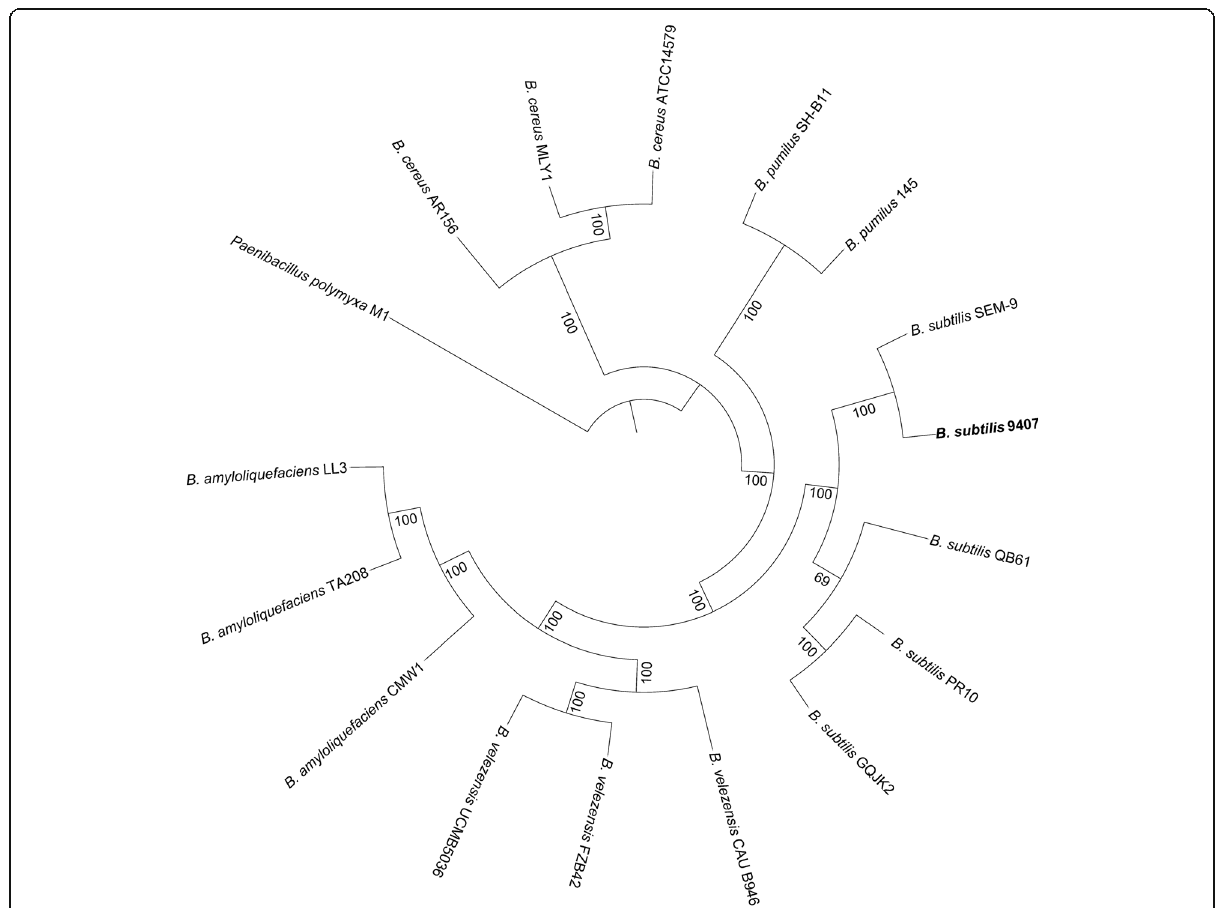
Fig. 1 Phylogenetic tree showing the relationship of the sequenced Bacillus spp. strains. The tree was generated based on the 662 single-copy core genes using RAxML 8.2.10. P. polymyxa M1 was used as the out-group. Percent bootstrap values (from 100 replicates) are indicated at the